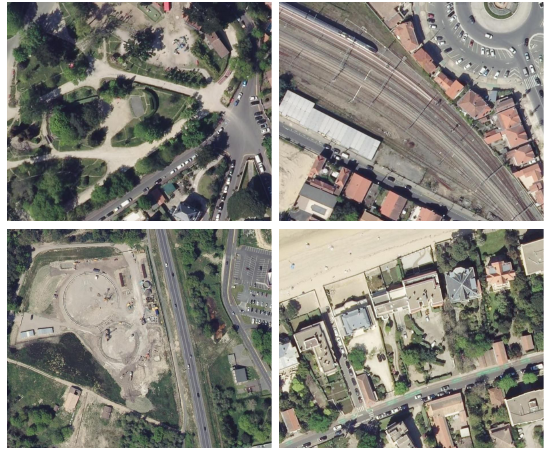
Figure 8. Example of mineral materials objects (path, railways, dumps,